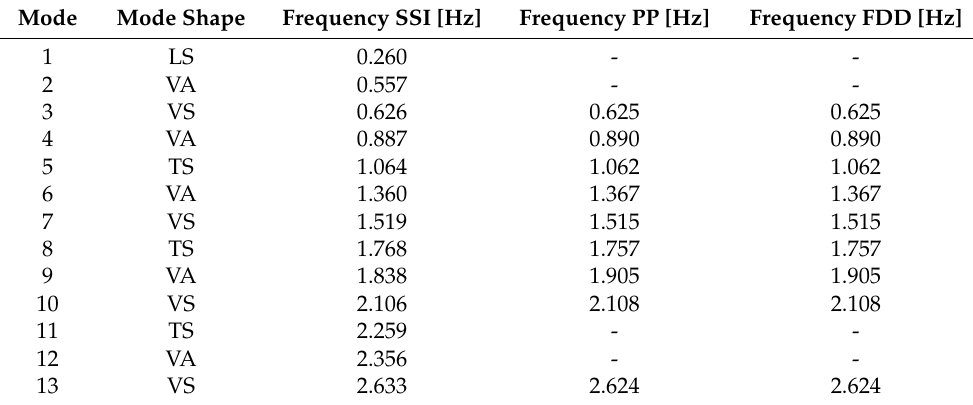
Table 1. Setup 1: Modal parameters of the footbridge obtained from the different identification techniques.